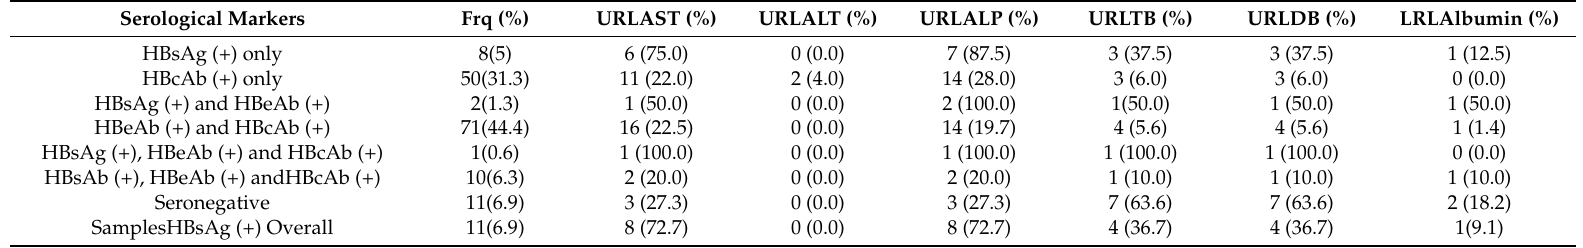
Table 1. Distribution of different combinations of hepatitis B virus (HBV) markers in relation to liver enzymes and compounds alteration among the study group ( n = 160).